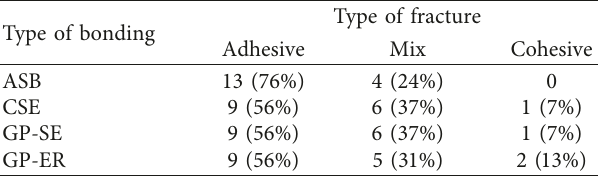
P value � 0.002 (ANOVA). Table 3: The frequency percentage of bond failure modes of dif- ferent adhesive systems to intracanal dentin of primary lateral incisors in the four